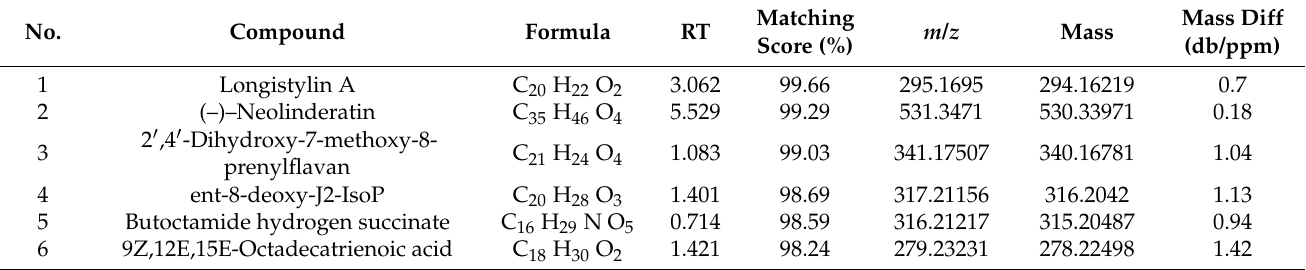
Table 1. Compounds identified from the ethanolic crude extract of S. cobularia according to